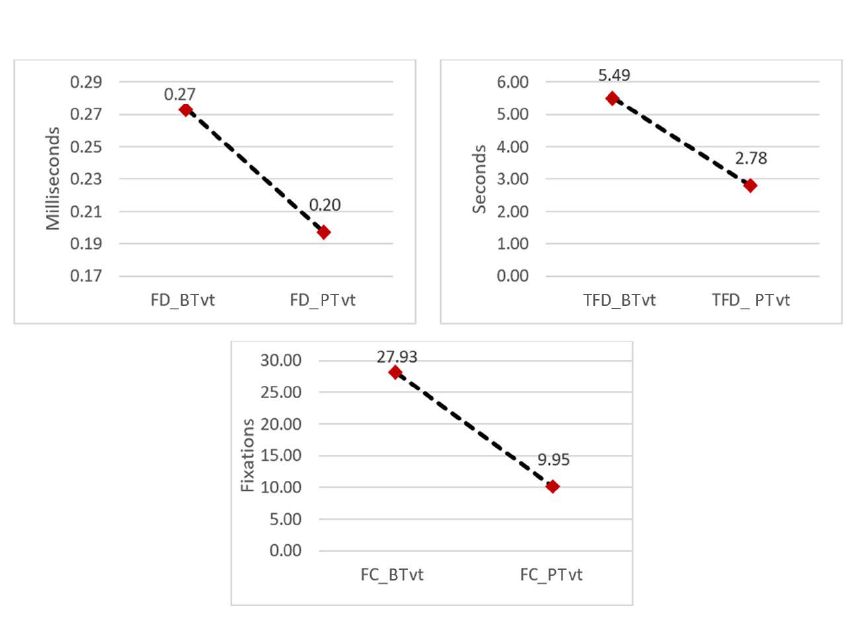
Figure 3. Marginal means of average fixation duration, total fixation duration and number of fixations for ads showing single bottles and packs of red